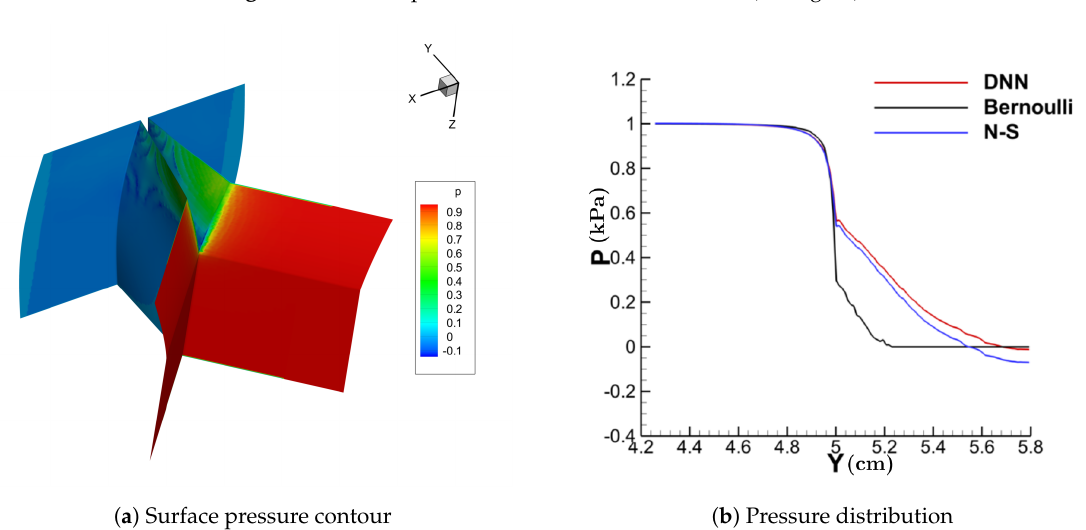
Figure 12. Surface pressure contour and distribution (divergent).